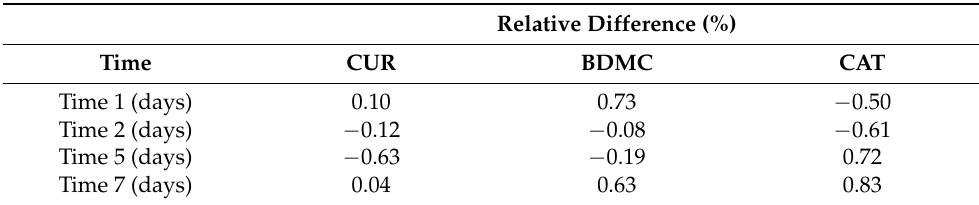
Table 5. Results obtained for the stability of the curcuminoid solutions stored at 5 ◦ C for 7 days. The stability was considered as the relative difference of the area response of 3.125 µ g/mL of curcuminoid solution between each stability time point and the freshly prepared solutions. Relative Difference (%)